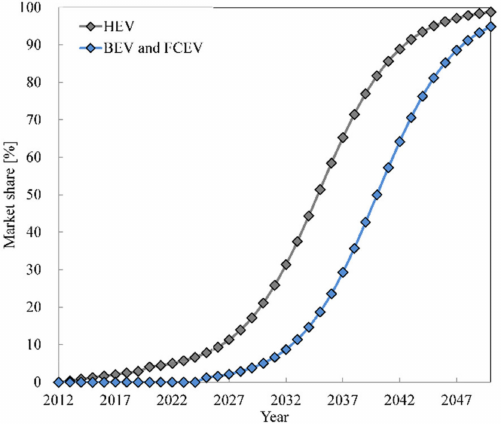
Figure 7. Technology di ff usion